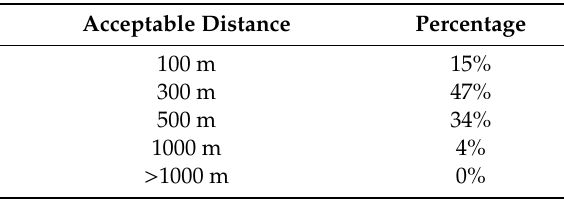
Table 3. Resident preferences survey: acceptable